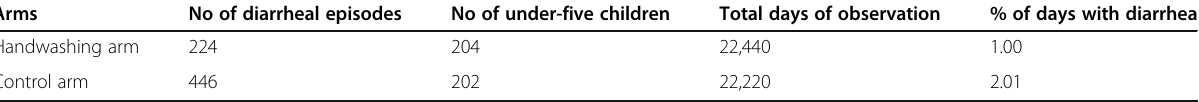
Table 3 Days gone with diarrhea against study arms in children under 5 year old, rural kebeles of Dire Dawa, east Ethiopia, 2019